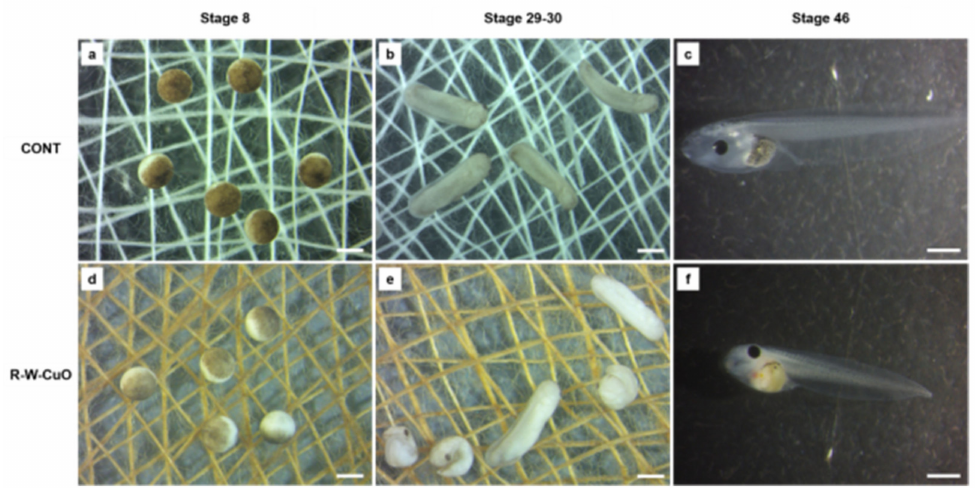
Figure 6. Stereomicroscopic images showing the experimental set up, with embryos in direct contact with uncoated cotton bandages ( a , b ) and CuO NP-coated bandages in water (W-CuO) ( d , e ), fixed at the bottom of glass petri dishes. Embryos were photographed at the beginning (stage 8) ( a , d ) and at the middle (stage 29–30 of the test). Larvae at the end of the test (stage 46) were screened for single malformations: ( c ), control larva; ( f ), W-CuO exposed larva showing irregular gut and body length shortening. Bars = 1